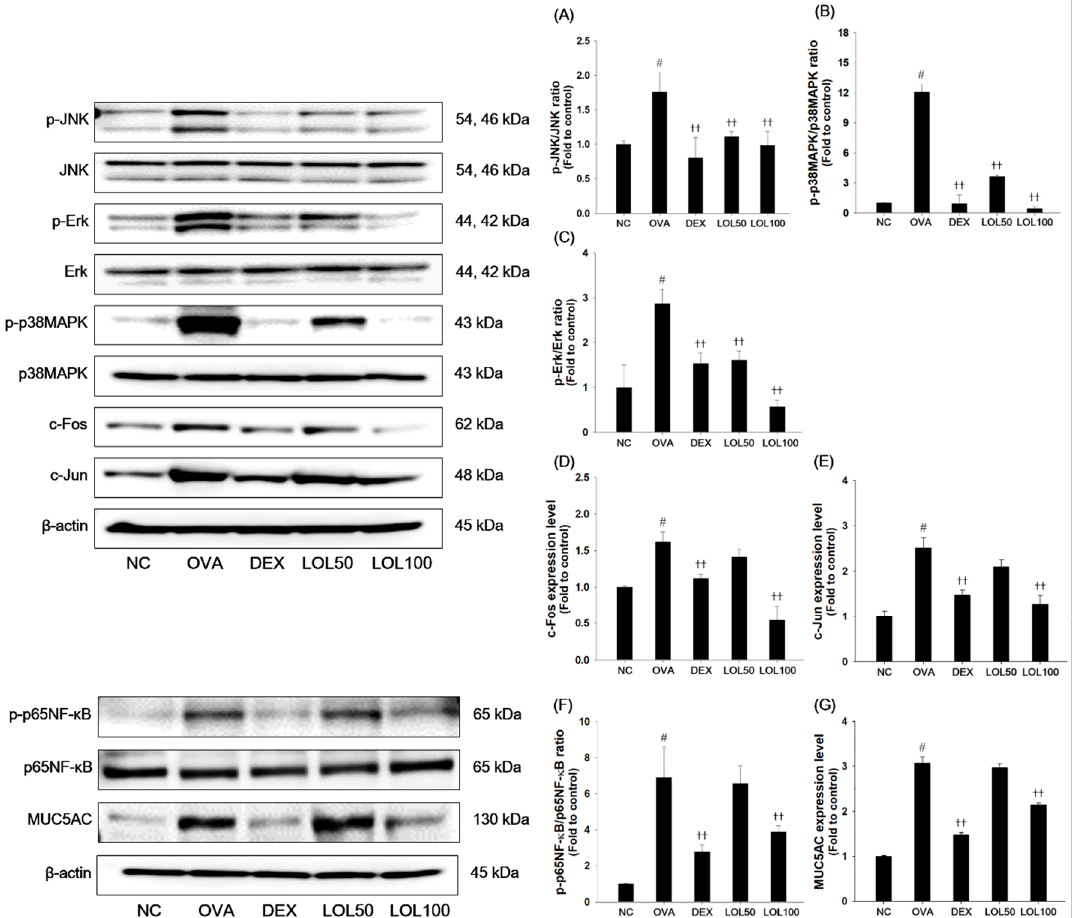
Figure 5. Effects of LOL on activation of MAPKs/AP-1, p65NF- κ B and expression of MUC5AC in OVA-challenged asthma model. The protein levels of ( A-E ) MAPKs/AP-1, ( F ) p65NF- κ B and ( G ) MUC5AC in the lung tissues were determined by western blot analysis. β -actin was used to confirm equal protein loading. NC: normal control mice; OVA: OVA-challenged asthma mice; DEX: dexamethasone (3 mg/kg) + OVA-challenged asthma mice; LOL: LOL (50 or 100 mg/kg) + OVA-challenged asthma mice. The values are expressed as the means ± SD ( n = 7/group). # p < 0.01, significantly different from NC group; †† p < 0.01, significantly different from OVA-challenged group.